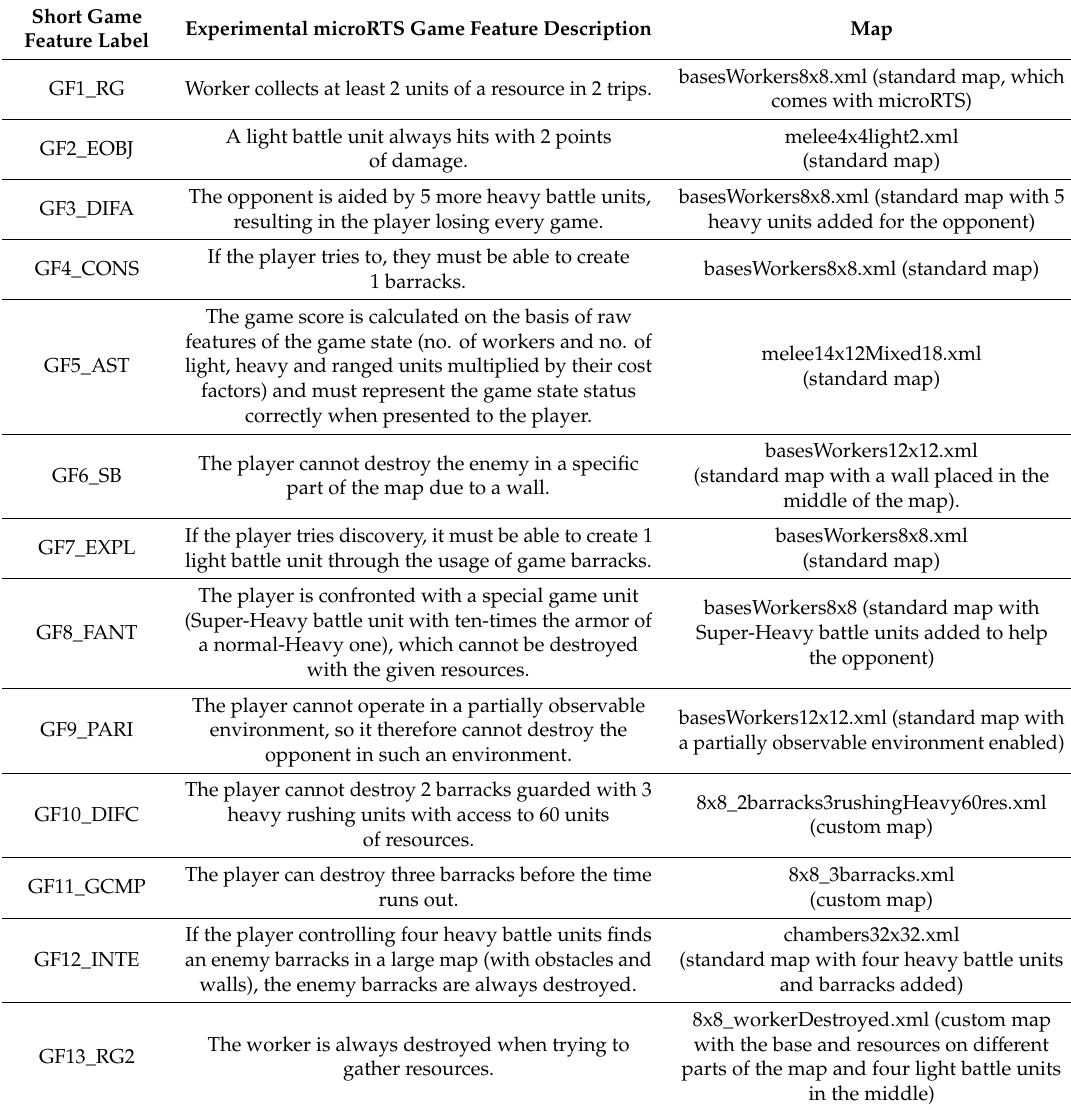
Table 5. microRTS game feature